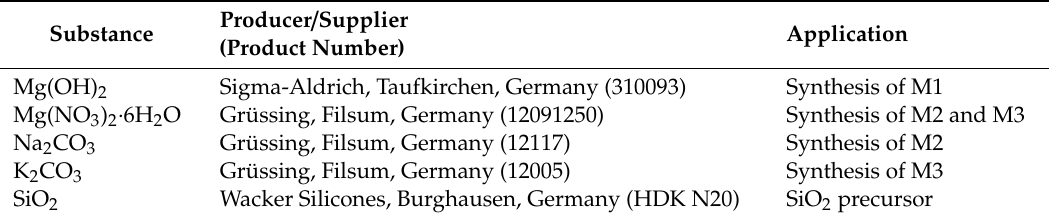
Table 4. Chemicals for the synthesis of mixed